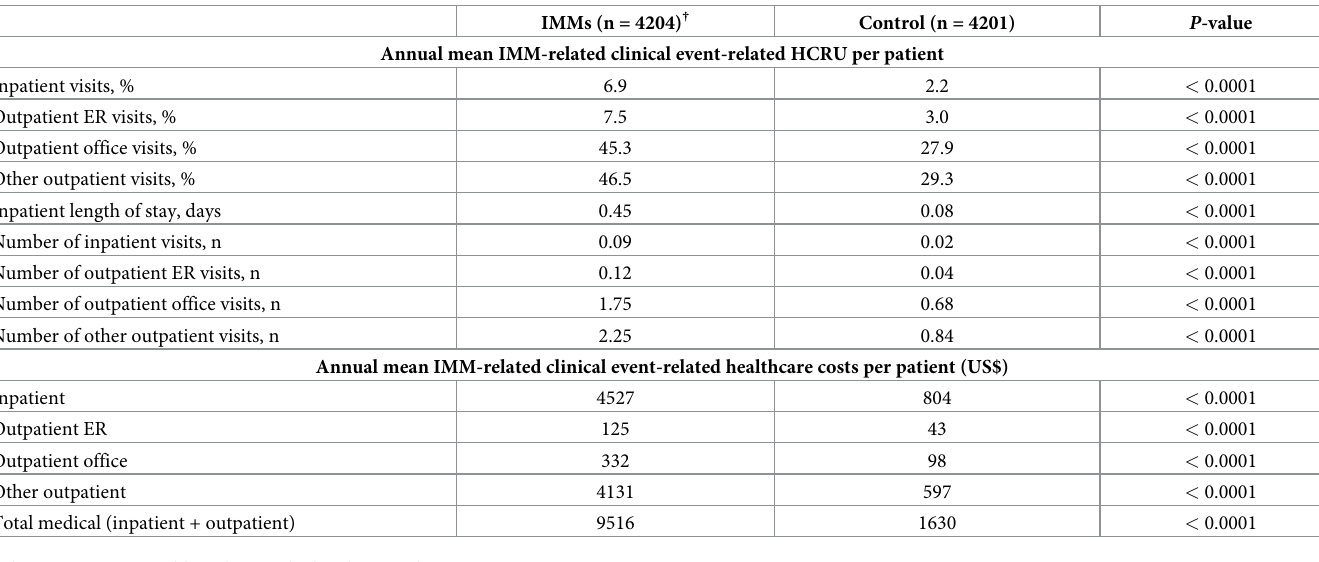
Table 2. Generalized linear model-adjusted healthcare resource utilization and costs associated with IMM-related clinical events. IMMs (n = 4204) † Control (n = 4201) P